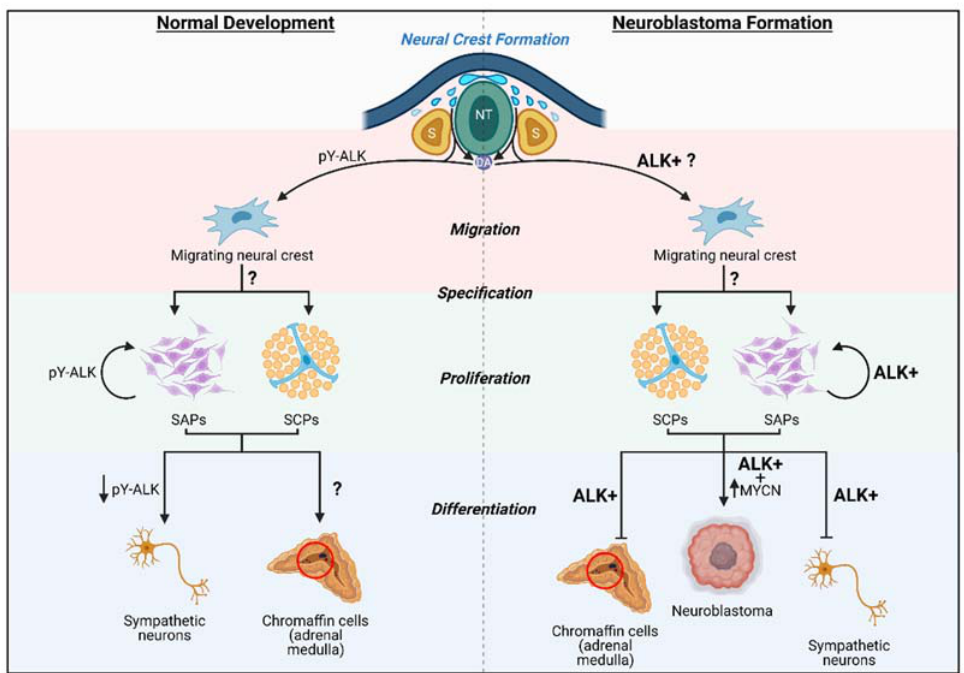
Figure 3. ALK in neural crest development and neuroblastoma formation. Normal development: neural crest progenitors arise from the dorsal neural tube. Cells undergo epithelial-to-mesenchymal transition, delaminate from the neural tube, and migrate, either laterally, adjacent to the somites (S), or towards the dorsal aorta (DA). The DA population of trunk neural crest cells start to specify into sympathoadrenal progenitor (SAP) cells or Schwann cell progenitors (SCP). These cells will eventually give rise to sympathetic neurons or chromaffin cells, respectively. Activated ALK (pY-ALK) can be found in migrating neural crest cells and is shown to be important in proliferation of SAP cells, but less so as they differentiate into sympathetic neurons. Neuroblastoma formation: ALK alterations (mutations, amplification, or translocation) can lead to constitutively active ALK (ALK+). During migration of neural crest cells, ALK+ is thought to increase their migratory behaviour. In addition, ALK F1174L/R1275Q have been shown to prolong SAP proliferation, which leads to the blockage of the differentiation into sympathetic neurons. The effect of ALK activation in SCPs and its involvement in neuroblastoma remains unclear. Recently, it has been proposed that ALK alterations potentiate MYCN oncogenic capacity, resulting in neuroblastoma formation [17,90,92–94,127,128]. NT = neural tube, DA = dorsal aorta, S = somite, pY-ALK = active ALK, SAP = sympathoadrenal progenitors, SCP = Schwann cell precursors, ALK+ = constitutively active ALK.